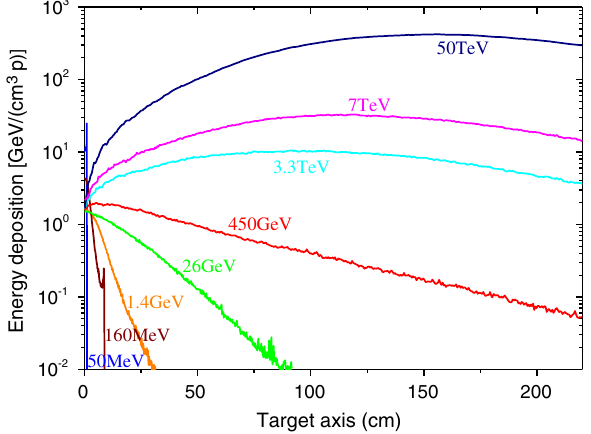
FIG. 14. Energy deposition per incident proton as a function of the depth into the solid graphite target at r ¼ 0 . The beam size is 0.2 mm for all the presented energies from 50 MeV to 50 TeV.